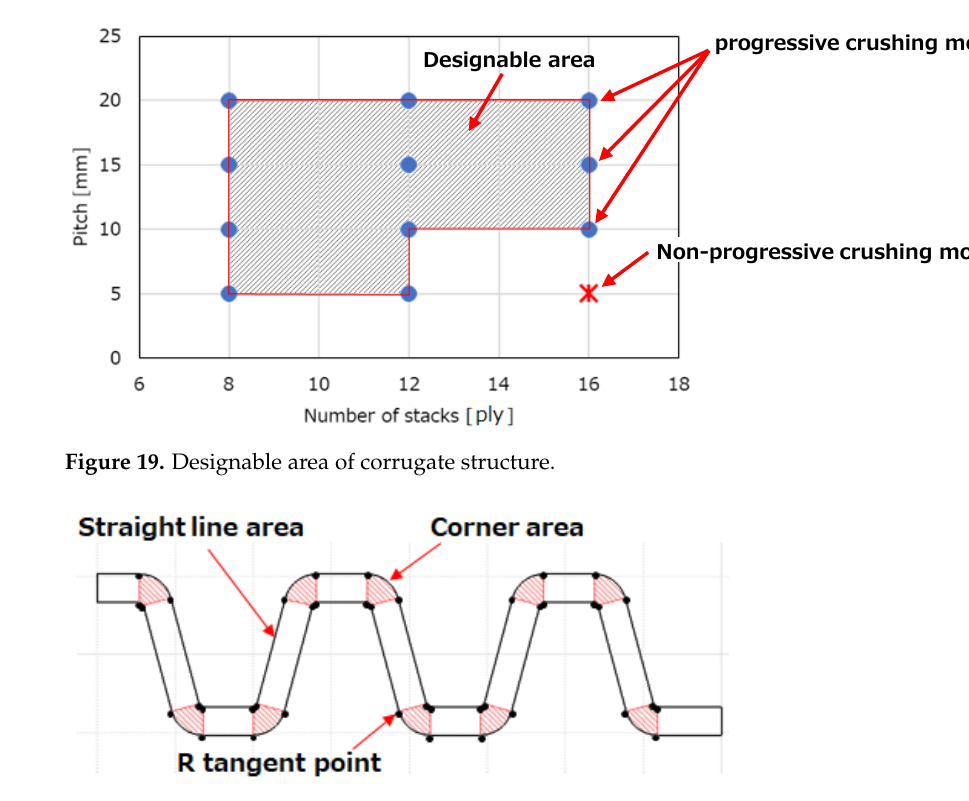
Figure 20. Straight-line and corner areas of corrugate structure. Table 9 shows the explanatory variables and response variable. Table 9. Explanatory variable and response variable (MCF).